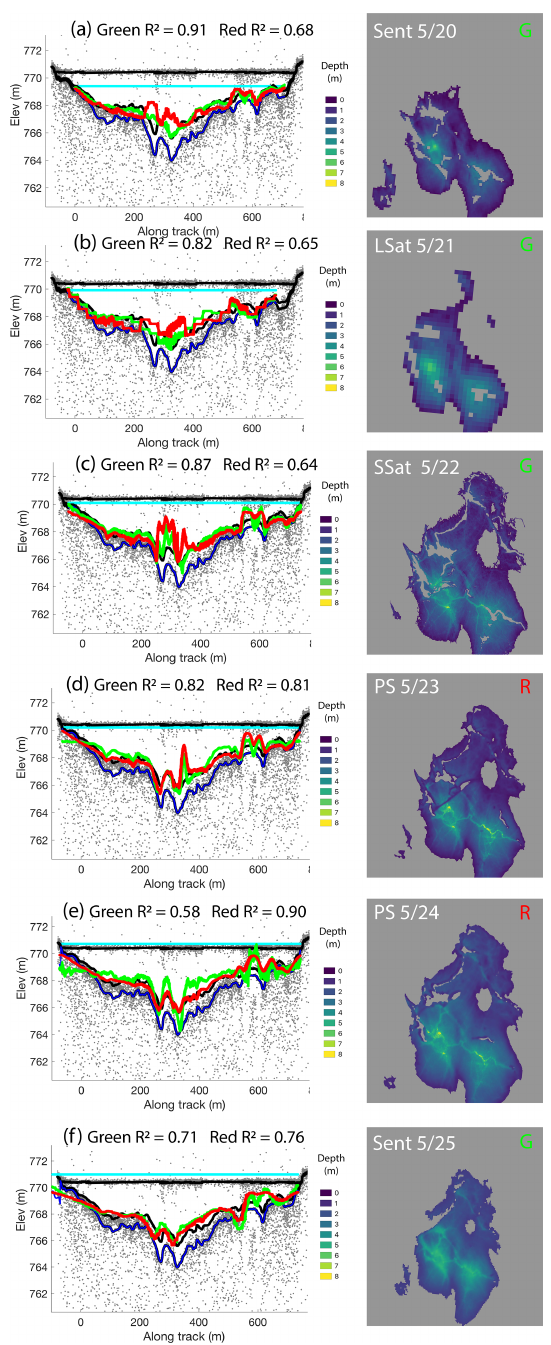
Figure 6. Lake Ay¸se, filling over 5d between 20 and 25 May with ICESat-2 pass on 23 May. Left column panels: profiles with Watta-calculated and imagery-derived depths from the green, indi- cated by “G”, and red, indicated by “R”, bands (with correspond- ing R 2 values inset; legend same as Fig. 4a). Right column pan- els: depth values derived from empirical estimate, with imagery source, date collected, and band used for depth estimate shown. Imagery source abbreviations are as follows: “LSat” for Land- sat, “SSat” for Planet SkySat, “PS” for Planet PlanetScope, and “Sent” for Sentinel-2. Path of ICESat-2 spot over Lake Ay¸se is shown in Fig.